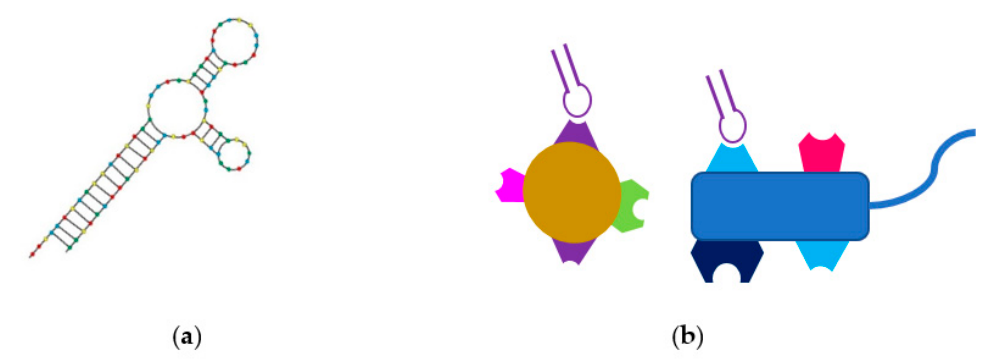
Figure 2. Schematic representation of a single aptamer and a bi-reactive aptamer. ( a ) A representation of a single aptamer ( b ) A schematic of a single aptamer able to bind to two different bacterial species [87]. Table 3. Aptamers currently generated against